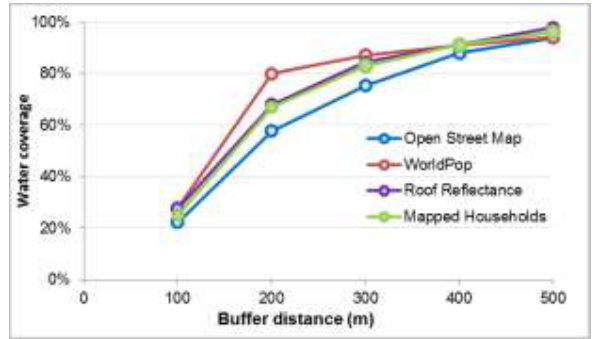
Figure 2: Comparison of water coverage calculated using four population data sources for a small town (~2,000 people)